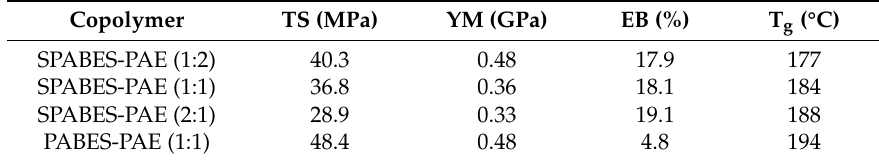
Table 2. The mechanical behaviors and glass transition temperature of block copolymers.